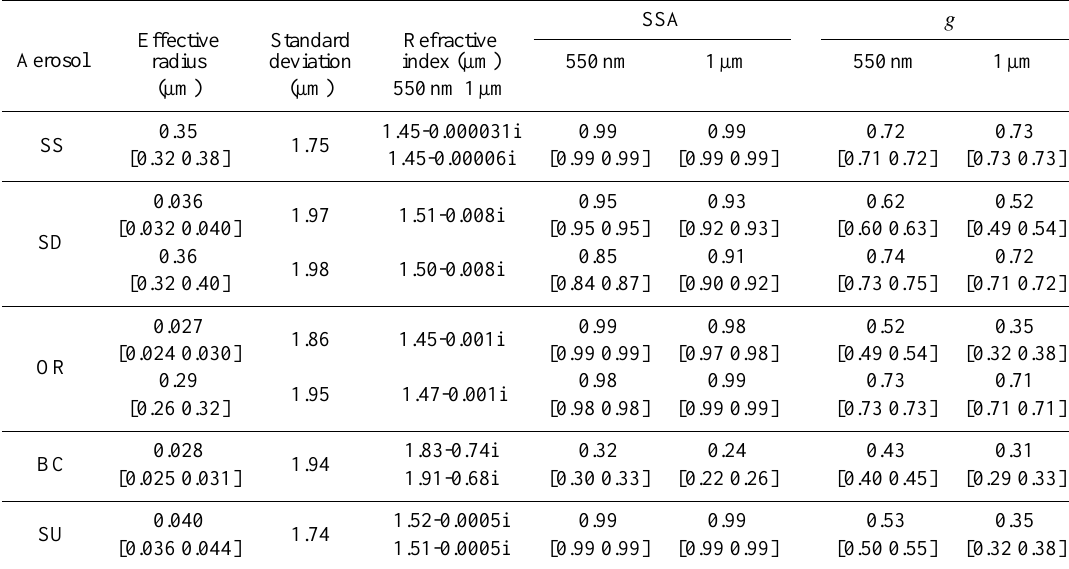
Table 6. Aerosol optical properties obtained from Mie calculations for different aerosol types at 550nm (first line for each aerosol) and 1µm (second line) wavelengths. Values between square brackets correspond to an uncertainty range of 10% on the effective radius. SSA=Single Scattering Albedo, g =asymmetry factor. These properties are provided in dry state. Changes on optical properties should be made depending on the relative humidity (Mallet et al.,